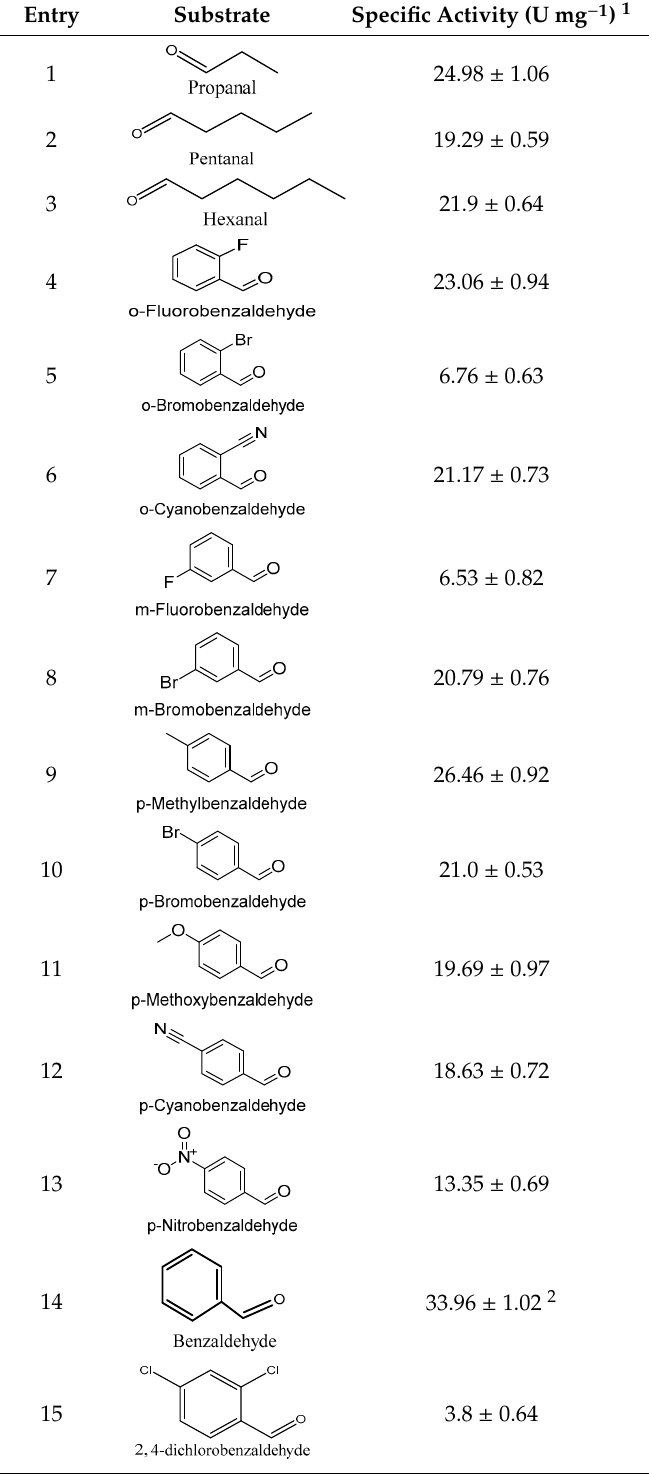
Table 1. The specific activity of CpCR against various aldehydes that were not reported earlier.